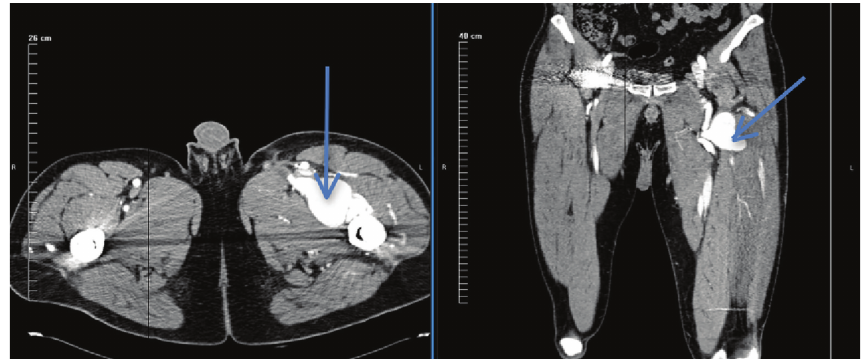
Figure 1: CT angiogram showing the left profunda femoris artery pseudoaneurysm.